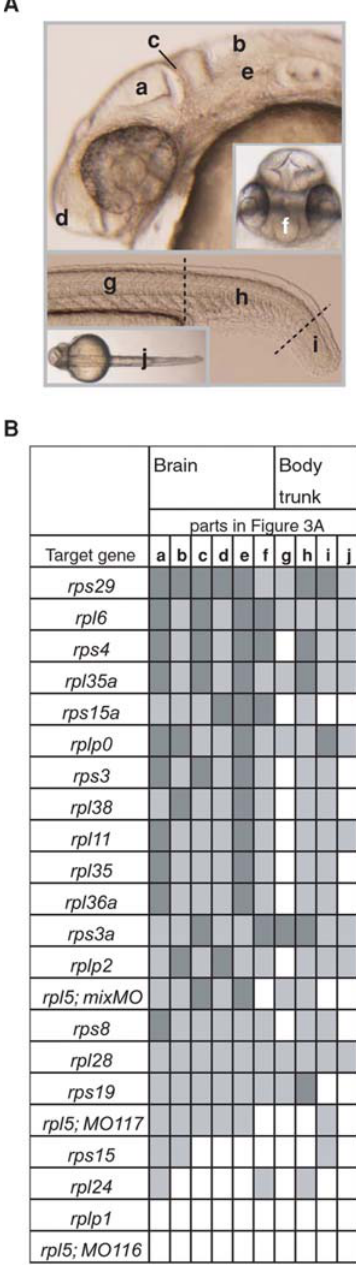
Figure 3. Schematic Representation of the Extent of Abnormalities in Brain and Body Trunk (A) 6 parts of the brain, 3 parts of the body trunk, and a dorsal view of the trunk are indicated in wild type embryo. a, optic tectum; b, 4th ventricle; c, midbrain-hindbrain boundary; d, anterior part of head; e, rhombencephalon; f, telencephalon; g, body along yolk sac extension; h, tail; i, tip of tail; j, dorsal view of the trunk. (B) The deformations were assessed using a 3-level severity scale; dark gray indicates a severe effect, light gray indicates a mild effect, and white represents no apparent effect. Detailed information and images of the abnormalities in the morphants are available at the zebrafish database (http://